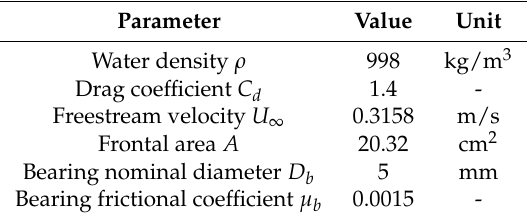
Table A1. Comparison of each configuration maximum recorded power